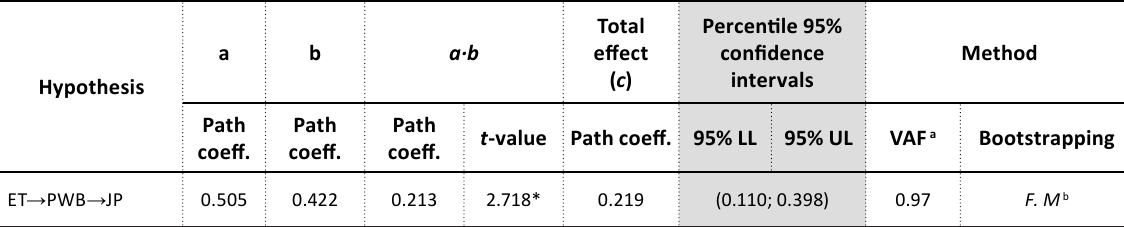
Table 4. Test of mediation using bootstrapping approach